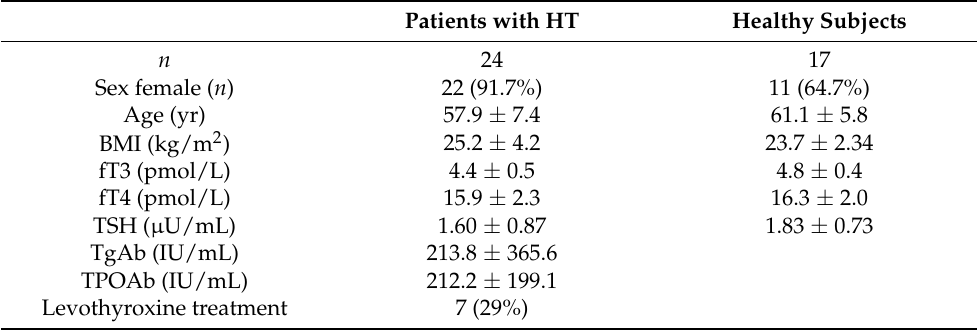
Table 2. Demographic data of patients with Hashimoto’s thyroiditis and healthy subjects. Frequency data are presented as number, (percentage), continuous data as mean ± standard deviation. HT, Hashimoto’s thyroiditis; n, number; BMI, body mass index; FT3, free triiodothyronine; FT4, free thyroxine; TSH, Thyroid stimulating hormone; TPOAb, thyroid peroxidase autoantibody; TgAb, thyroglobulin autoantibody. Normal ranges of fT3, 3.0–6.3 pmol/L; fT4, 9.5–24 pmol/L; TSH,